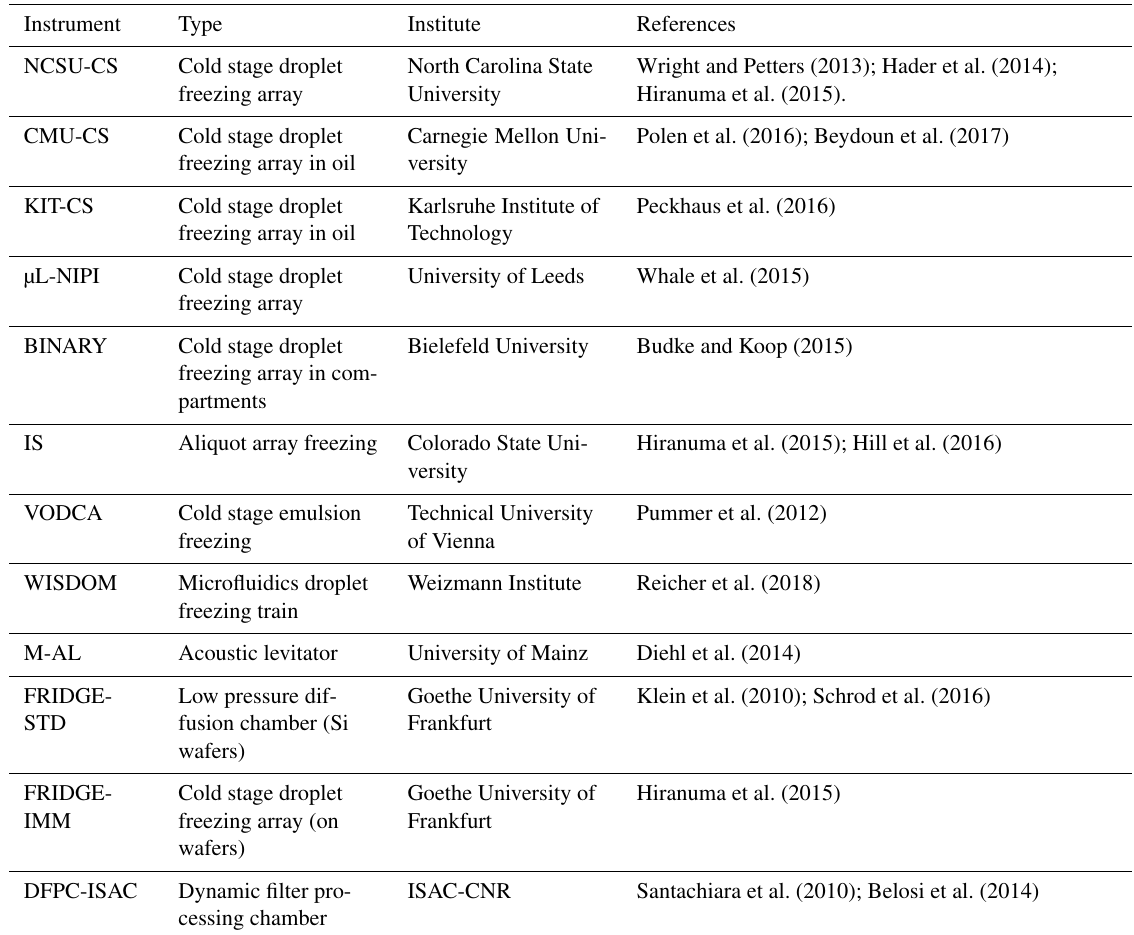
Table 2. Post-processing INP instruments.